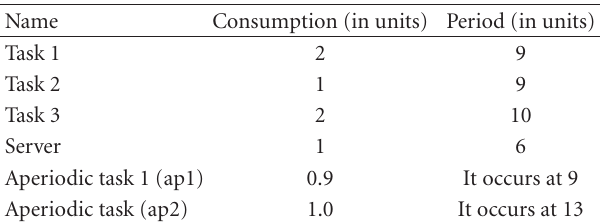
Table 2: Second example of PE.